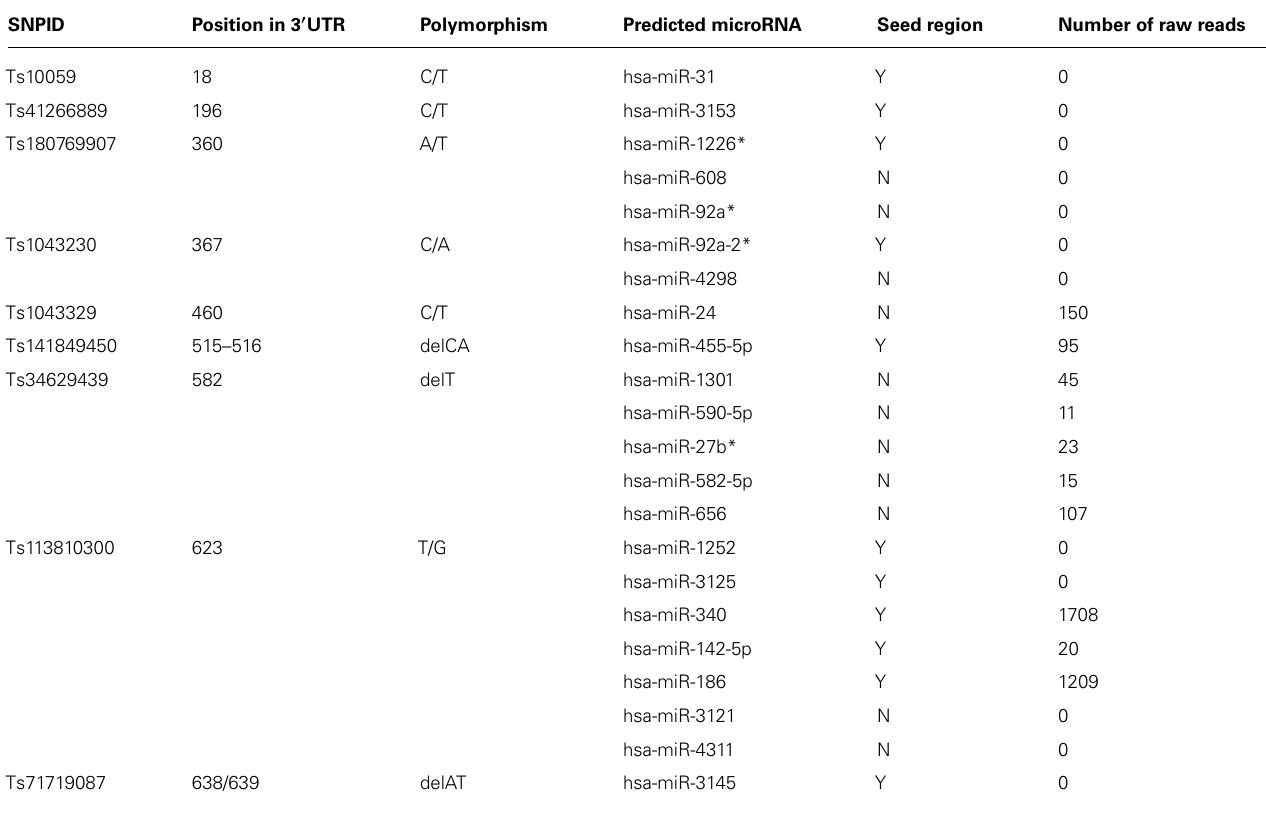
Table 1 | Polymorphisms located in or near miRNA target sites located in the 3 (cid:2) UTR of hNCSTN. SNPID Position in 3 (cid:2) UTR Polymorphism Predicted microRNA Seed region Number of raw